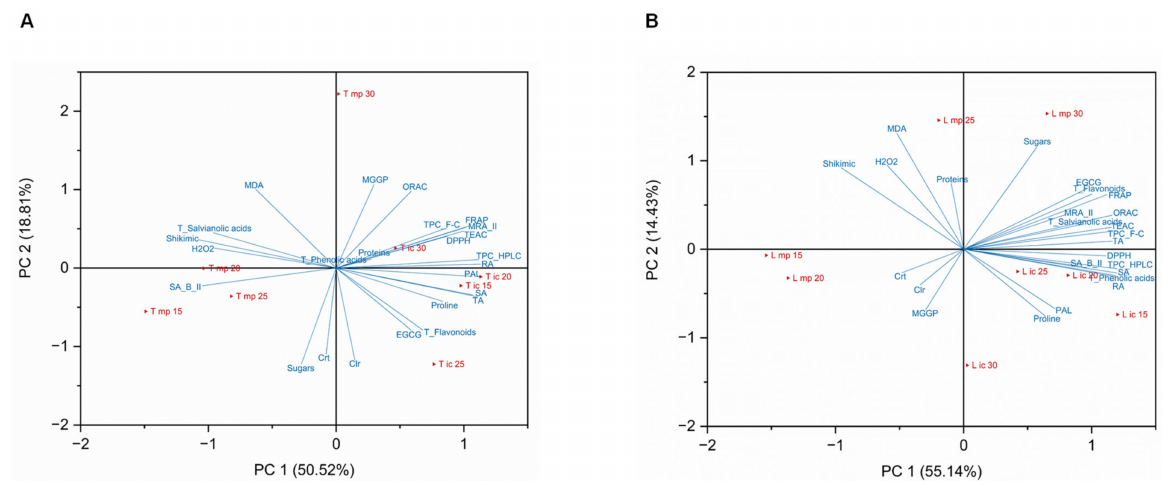
Figure 6. Principal component analysis (PCA) biplot of the different parameters studied, namely photosynthetic pigments (chlorophylls and carotenoids), oxidative stress indicators (H 2 O 2 and MDA), osmoprotectants (proline, soluble sugars, soluble proteins), shikimic/phenylpropanoid intermediates (PAL activity, shikimic acid content), total phenolic content (F-C and HPLC), total phenolic acids con- tent (HPLC), total salvianolic acids content (HPLC), total flavonoids content (HPLC), most abundant individual phenolic compounds (HPLC), namely epigallocatechin gallate (EGCG), theaflavic acid (TA), salvianolic acid B isomer II (SA_B_II), methylrosmarinic acid isomer II (MRA_II), rosmarinic acid (RA), salvianolic acid A isomer II (SA_A_II), methyl 6-O-galloyl- β -D-glucopyranoside (MGGP), sagerinic acid (SA), and antioxidant activity (DPPH, ABTS, FRAP, ORAC) in ( A ) T. lotocephalus in vitro cultures (T ic) and micropropagated plants (T mp), and ( B ) L. viridis in vitro cultures (L